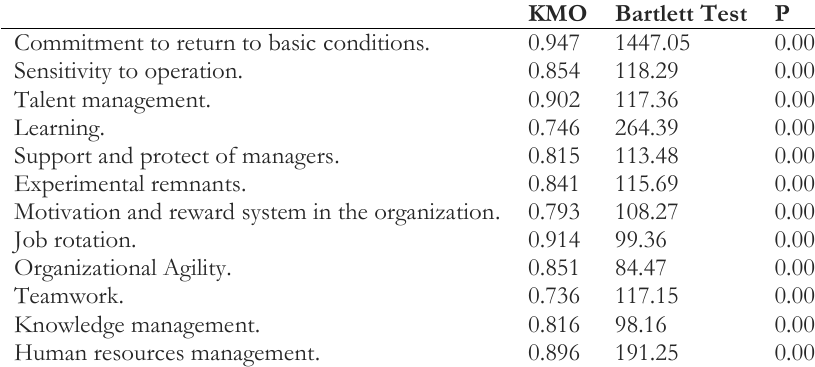
Table 4. KMO rate and Bartlett test (source: software